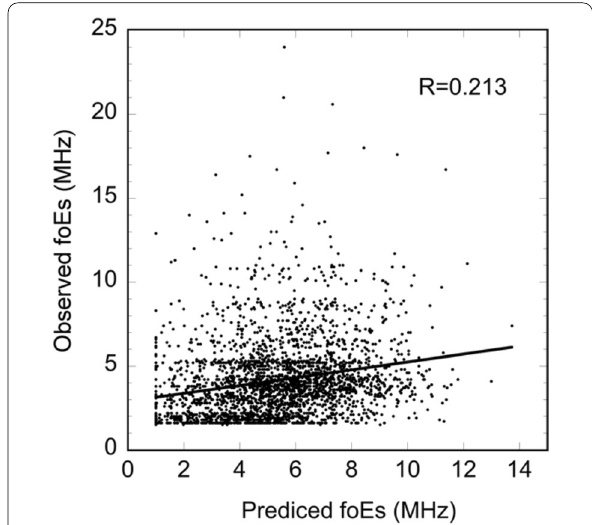
Fig. 13 Correlation coefficients of the observed foEs and predicted foEs . Scatter plots and correlation coefficients of 1-h data of the observed foEs and the predicted foEs are shown using the data from DOY 179 to DOY 299 at Okinawa in